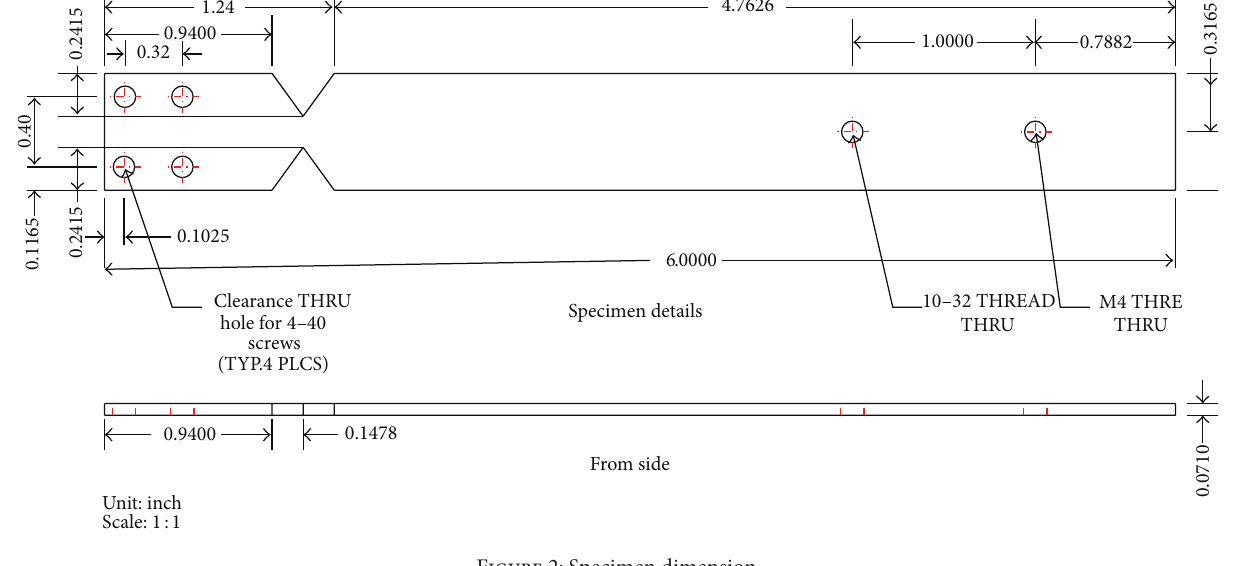
Figure 2: Specimen dimension.